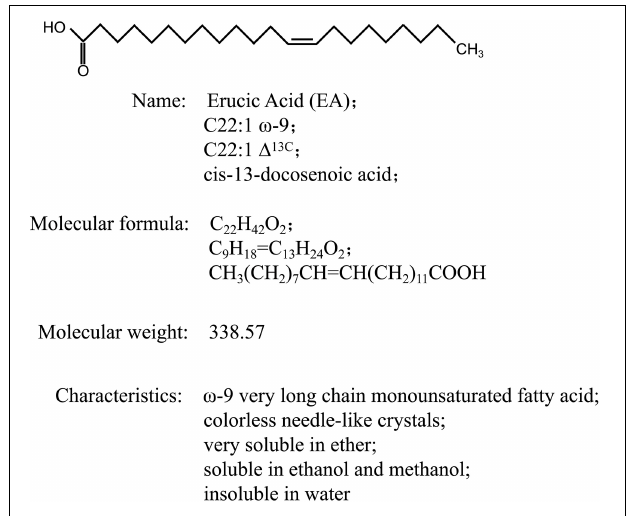
FIGURE 1 | Chemical structure and other basic information of erucic